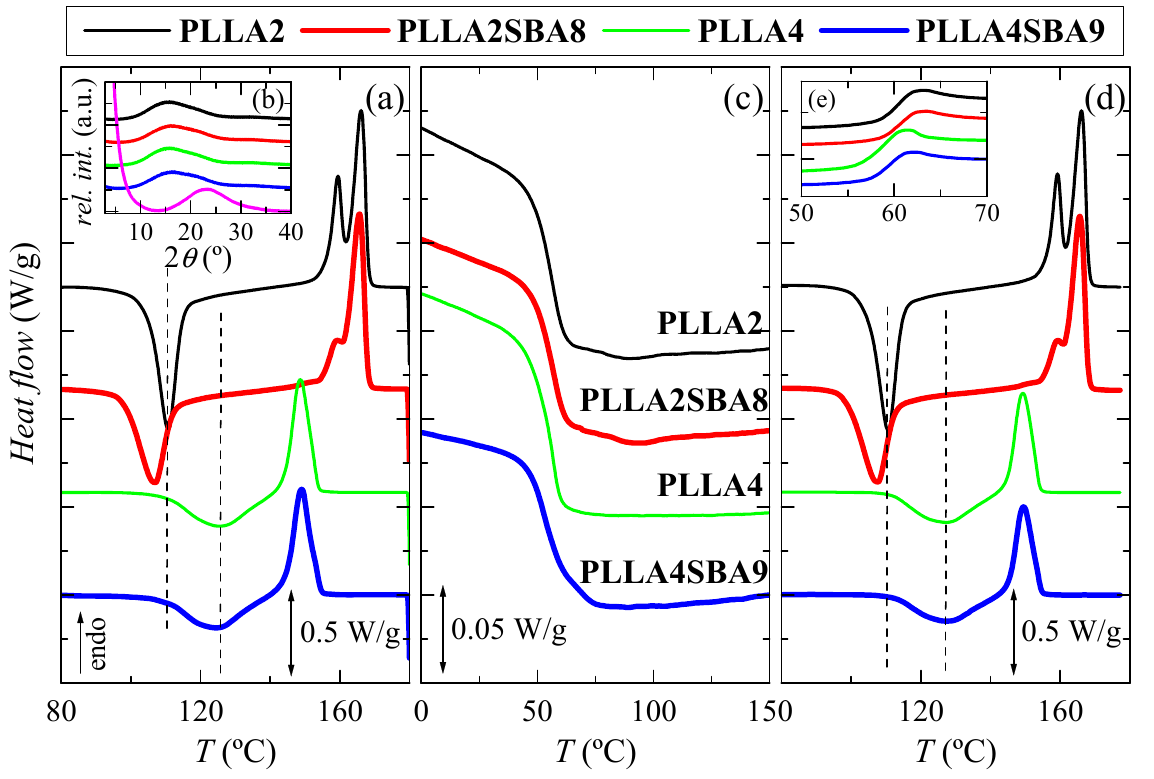
Figure 3. DSC curves carried out at 10 ◦ C/min for the two PLLA analyzed, PLLA2 and PLLA4, and their hybrids with SBA-15, PLLA2SBA8 and PLLA4SBA9: ( a ) first heating; inset ( b ) X-ray patterns at room temperature in the wide-angle interval; magenta profile is the one for the pristine SBA-15 particles; ( c ) cooling from the melt; ( d ) second heating, and inset ( e ) glass transition interval during second